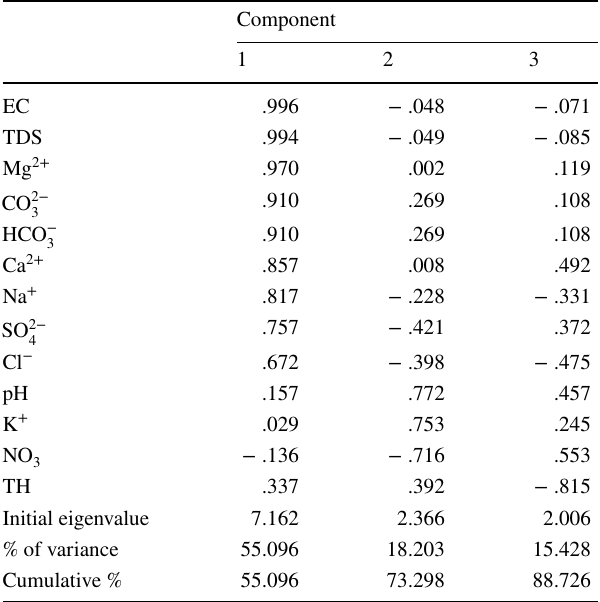
Table 7 Factor loading and eigenvalues of extracted components dur- ing wet